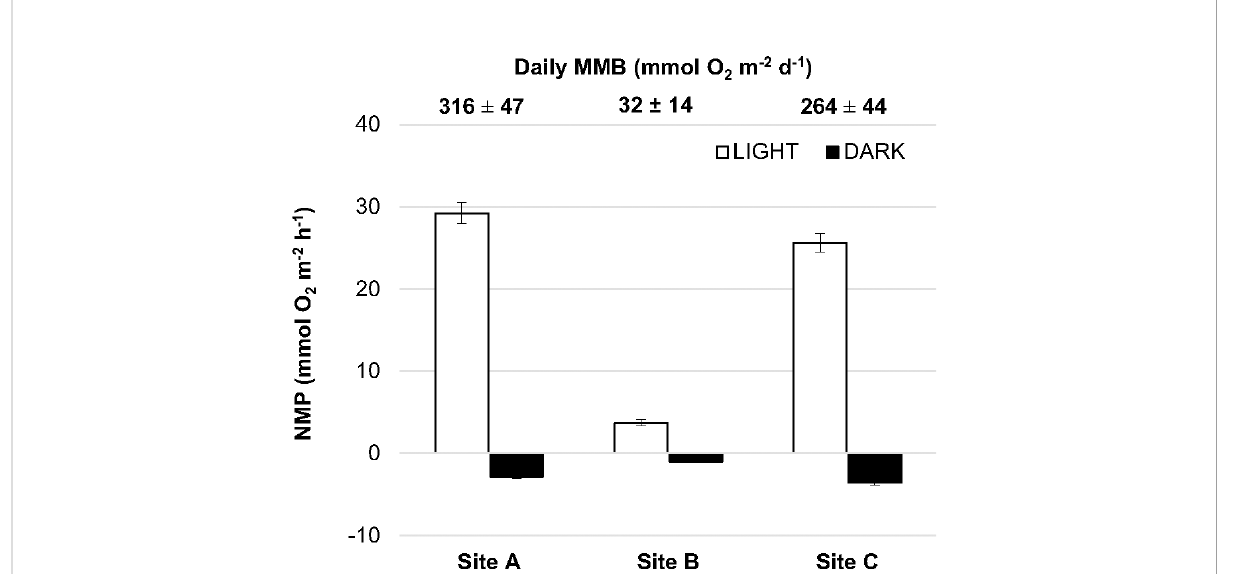
FIGURE 3 Seagrass net meadow productivity measured in light (white columns) and dark (black columns) conditions. Bars are mean ± SEM. Numbers above indicate the daily seagrass meadow metabolic balance (MMB) (mean ± SD) for each site.